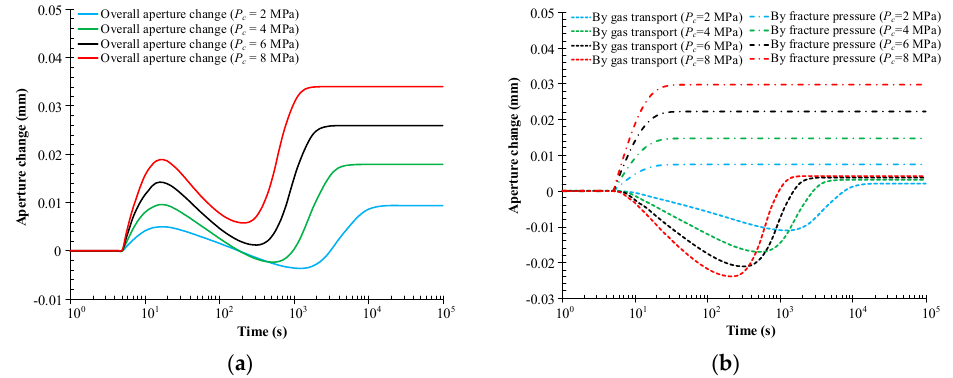
Figure 15. Evolution of fracture aperture change for different injection pressure increments. ( a ) Overall aperture change; ( b ) aperture change induced by fracture pressure and gas transport in matrix.